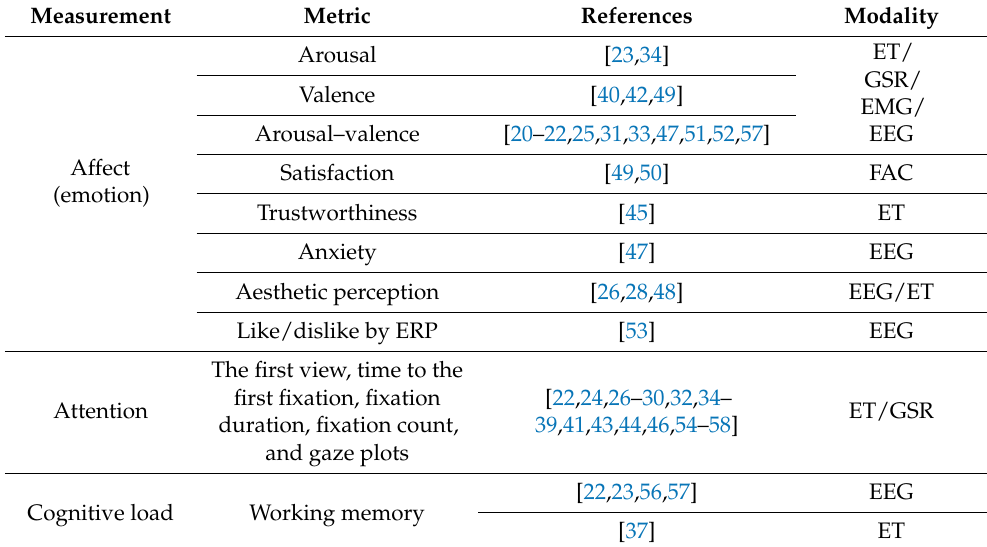
Table 4. Neuro-tourism